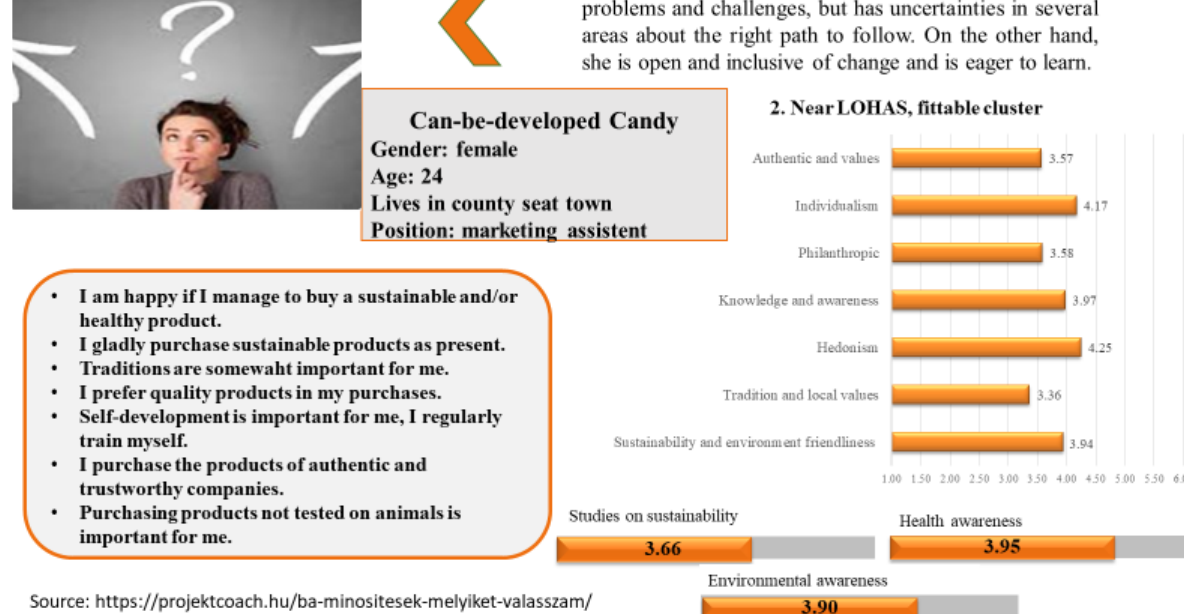
Figure 3. ‘Can-be-developed’—the persona that nearly fits the LOHAS model. Source: Authors’ own compilation based on the results of cluster analysis, 2022.